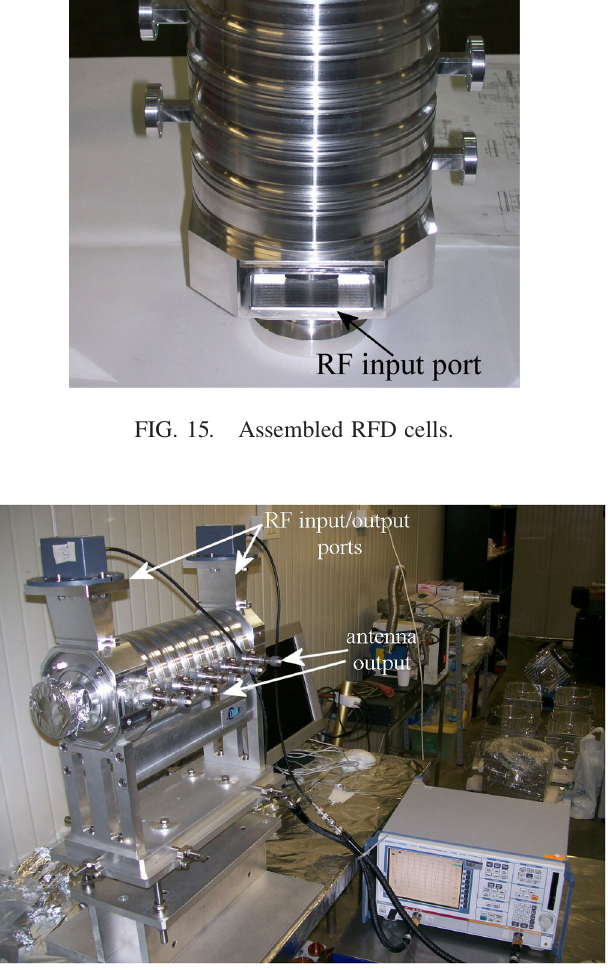
FIG. 16. RFD under